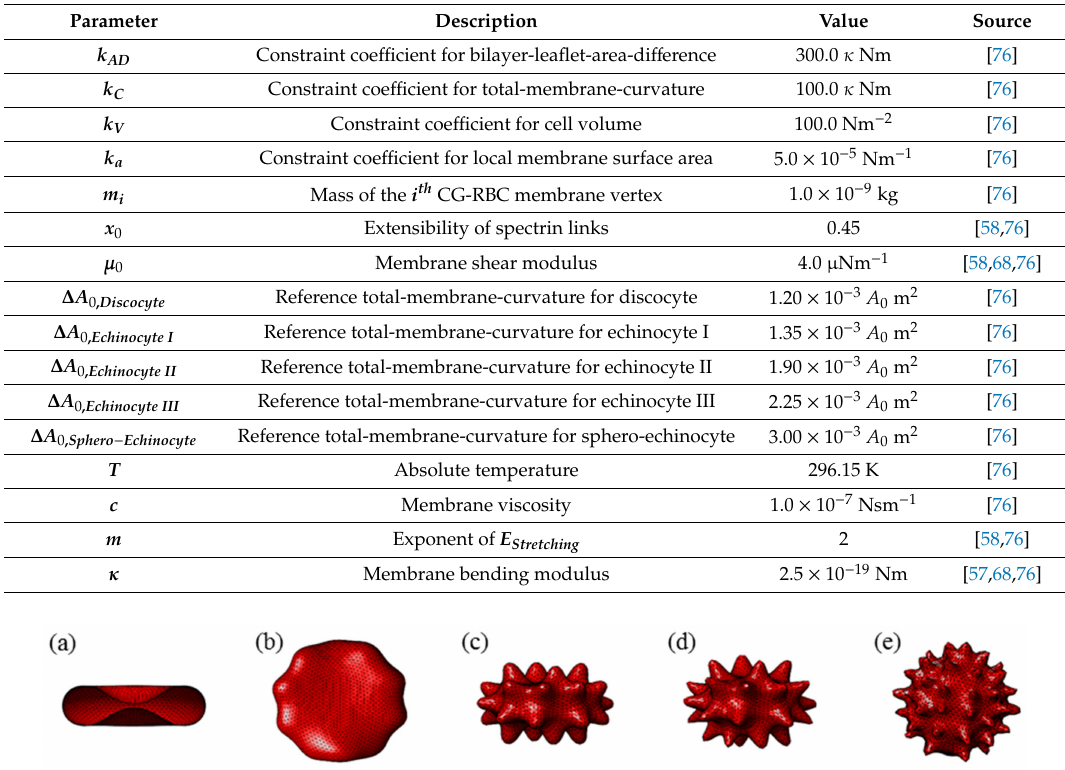
Figure A1. The CG-RBC membrane model-predicted ( a ) discocyte, ( b ) echinocyte I, ( c ) echinocyte II, ( d ) echinocyte III and ( e ) sphero-echinocyte morphologies at model parameters given in Table A1.